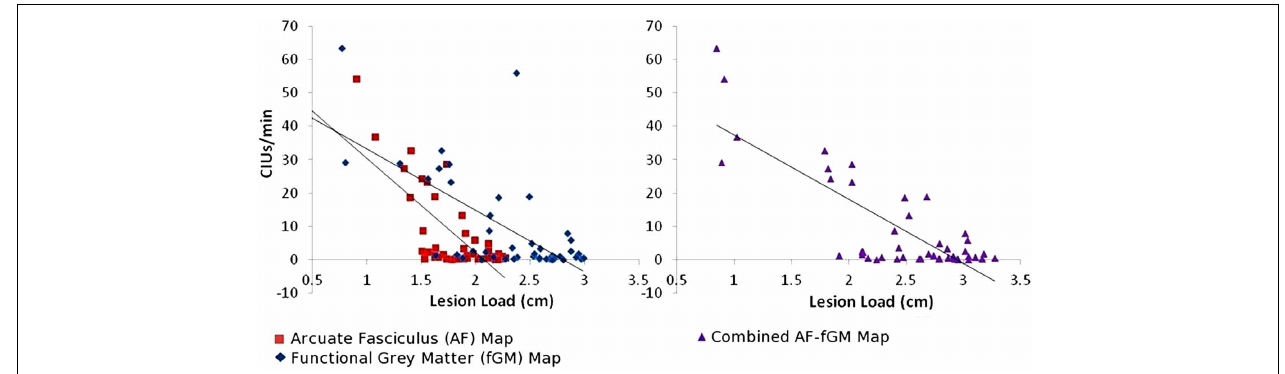
FIGURE 2 | CIUs/min vs. AF-, fGM-, and Combined AF-fGM lesion loads. Lesion load is displayed on the X -axis, and CIUs/min is displayed on the Y -axis. AF-LL is shown in red, fGM lesion load is shown in blue, and combined